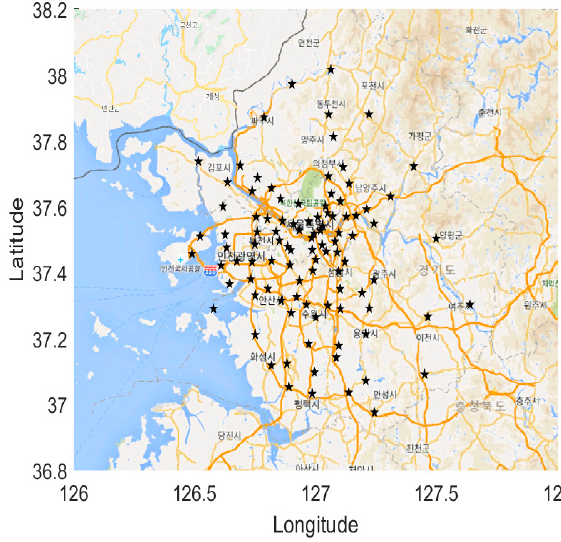
Figure 7. Location of repositioned vertiports.